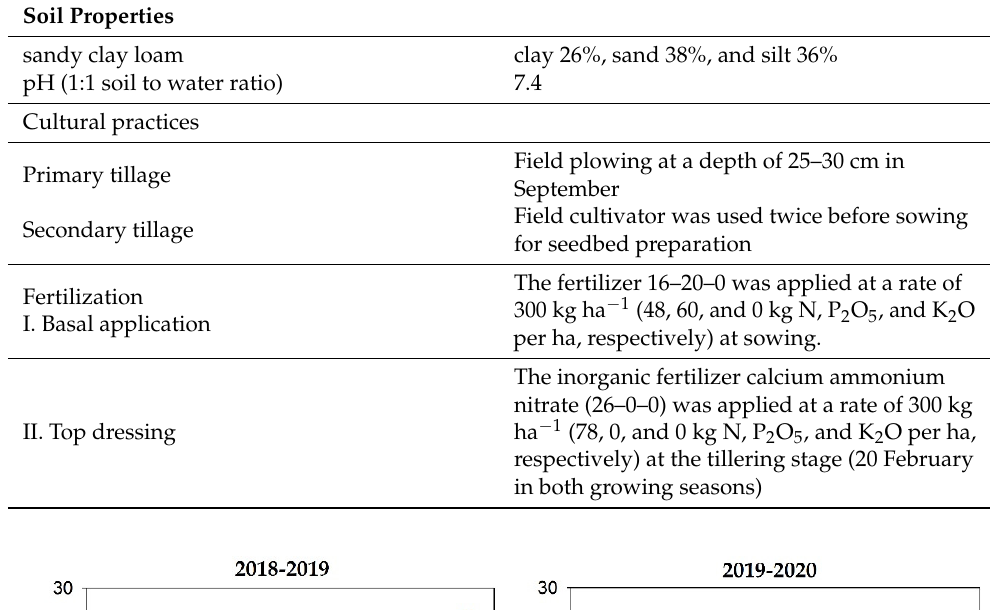
Table 1. Soil properties and main cultural practices applied on the wheat crop.